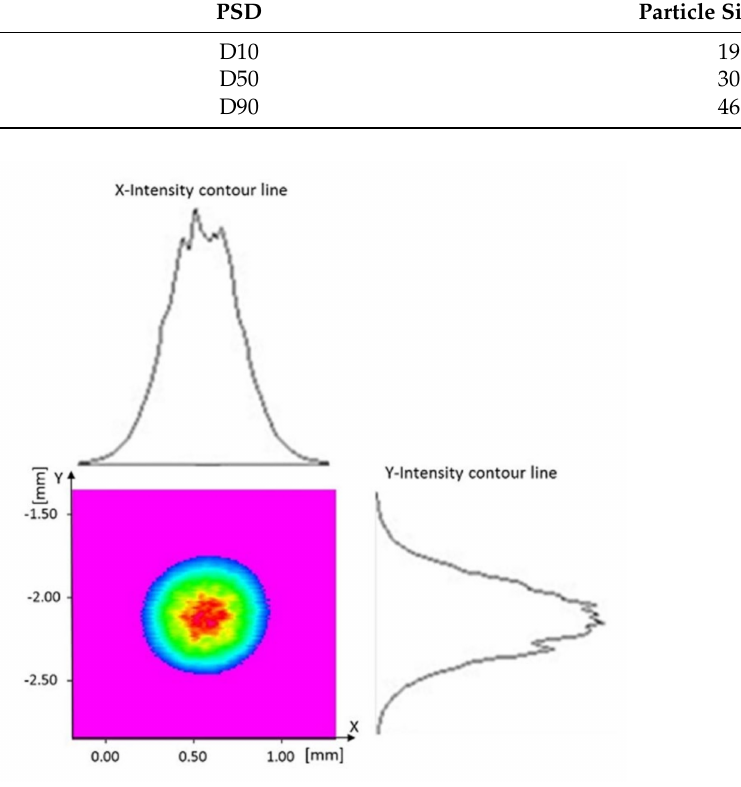
Figure 1. Intensity distribution profiles for the laser beam, after passage through the fiber, as a function of radial coordinates and cross-sectional